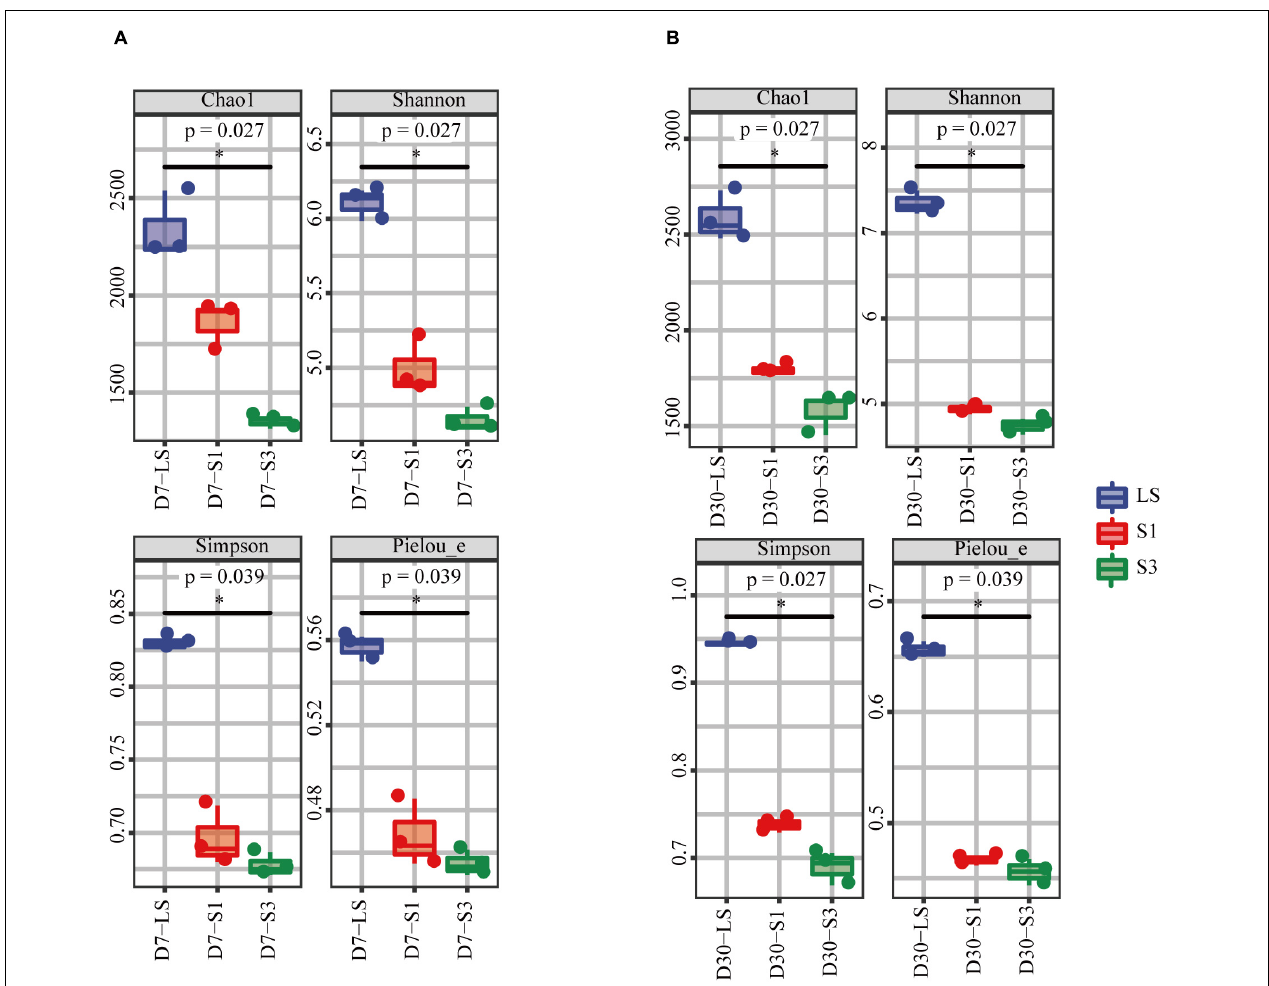
FIGURE 5 | Alpha diversity index of bacterial communities in soils from the different salinity treatments. (A) the 7 th day, (B) the 30 th day.